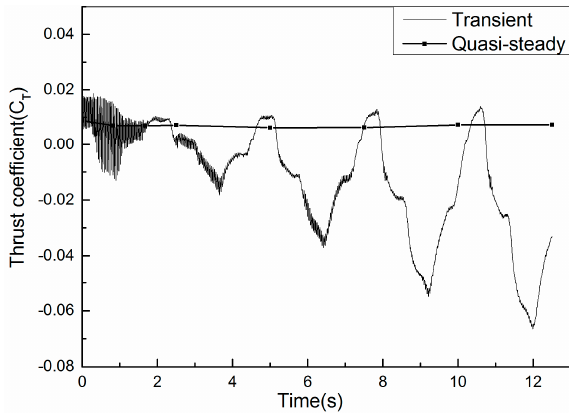
Figure 8. Time history of the rotor thrust coefficient.